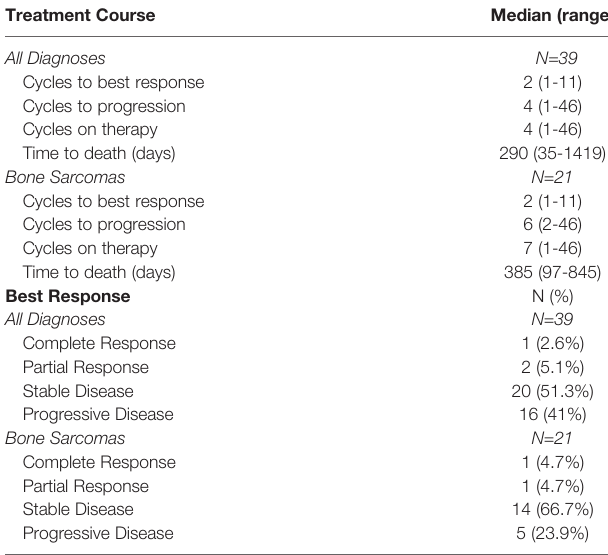
TABLE 3 | Treatment Duration and Best